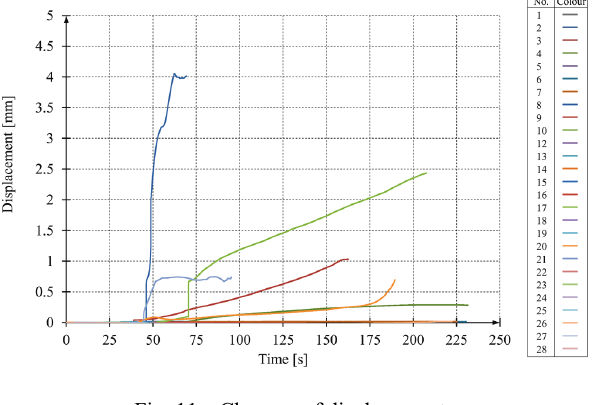
Fig. 11a. Changes of displacements measured on base B (Fig. 5)